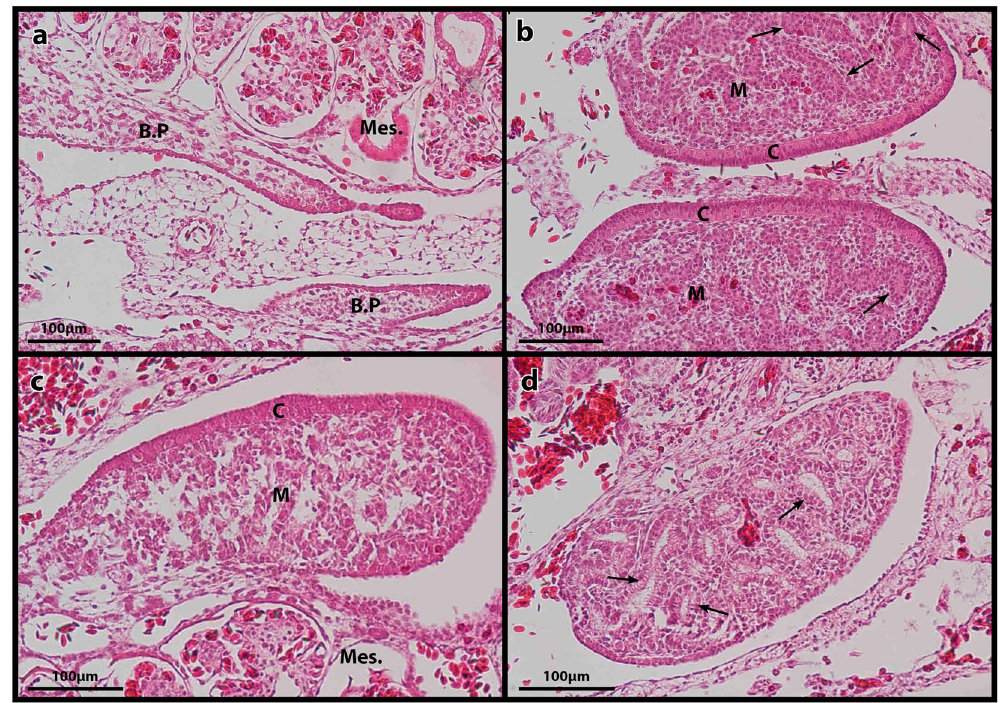
Figure 2. Histological sections of embryonic Pogona vitticeps urogenital systems stained with haematoxylin and eosin (H & E). ( a ) Bipotential gonads with developing cortex and medullary regions during migration towards the anterior mesonephros. ( b ) Ovotestes from an embryo incubated at 36 °C undergoing sex reversal showing a proliferating cortex with oogonia, a medulla with numerous rudimentary seminiferous tubules. ( c ) Differentiated ovary with a reducing medulla, cortex proliferating with oogonia. ( d ) Differentiated testes with a reducing cortex, and medulla with developing seminiferous tubules. B. P = bipotential gonad, Mes. = mesonephros, C = cortex, M = medulla, black arrows = seminiferous